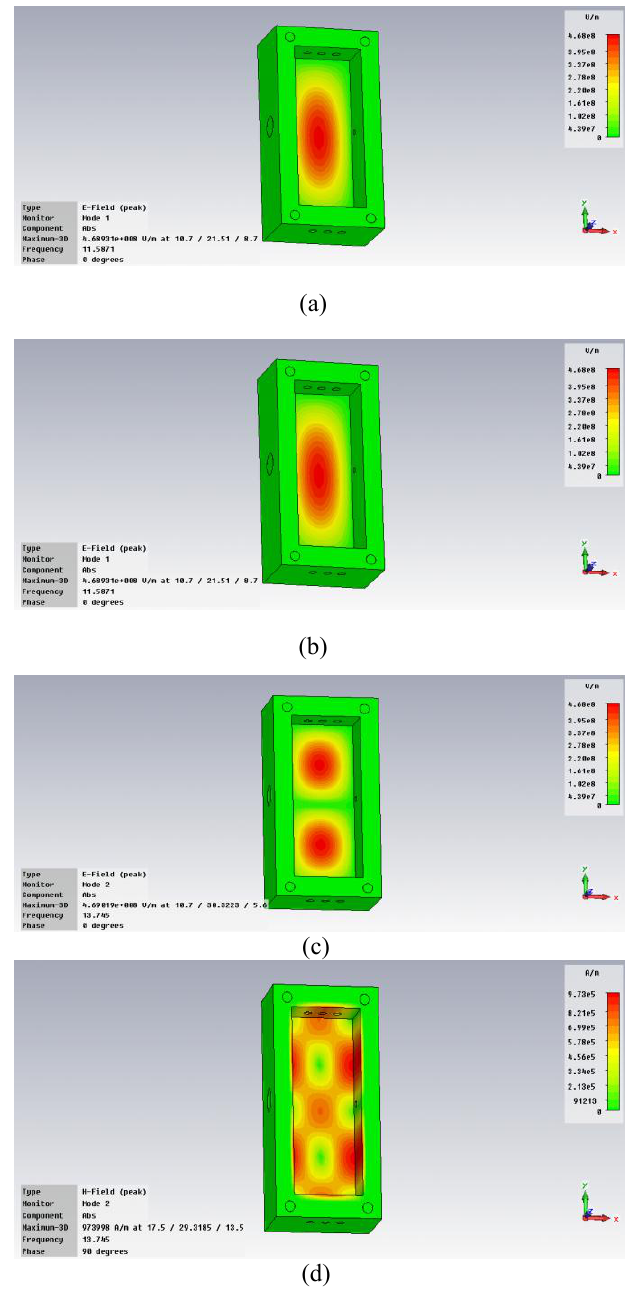
Figure 3: Eigen mode simulation in unassembled cavity: a) Mode 1 E field b) Mode 1 H Field c) Mode 2 E-field and d) Mode 2